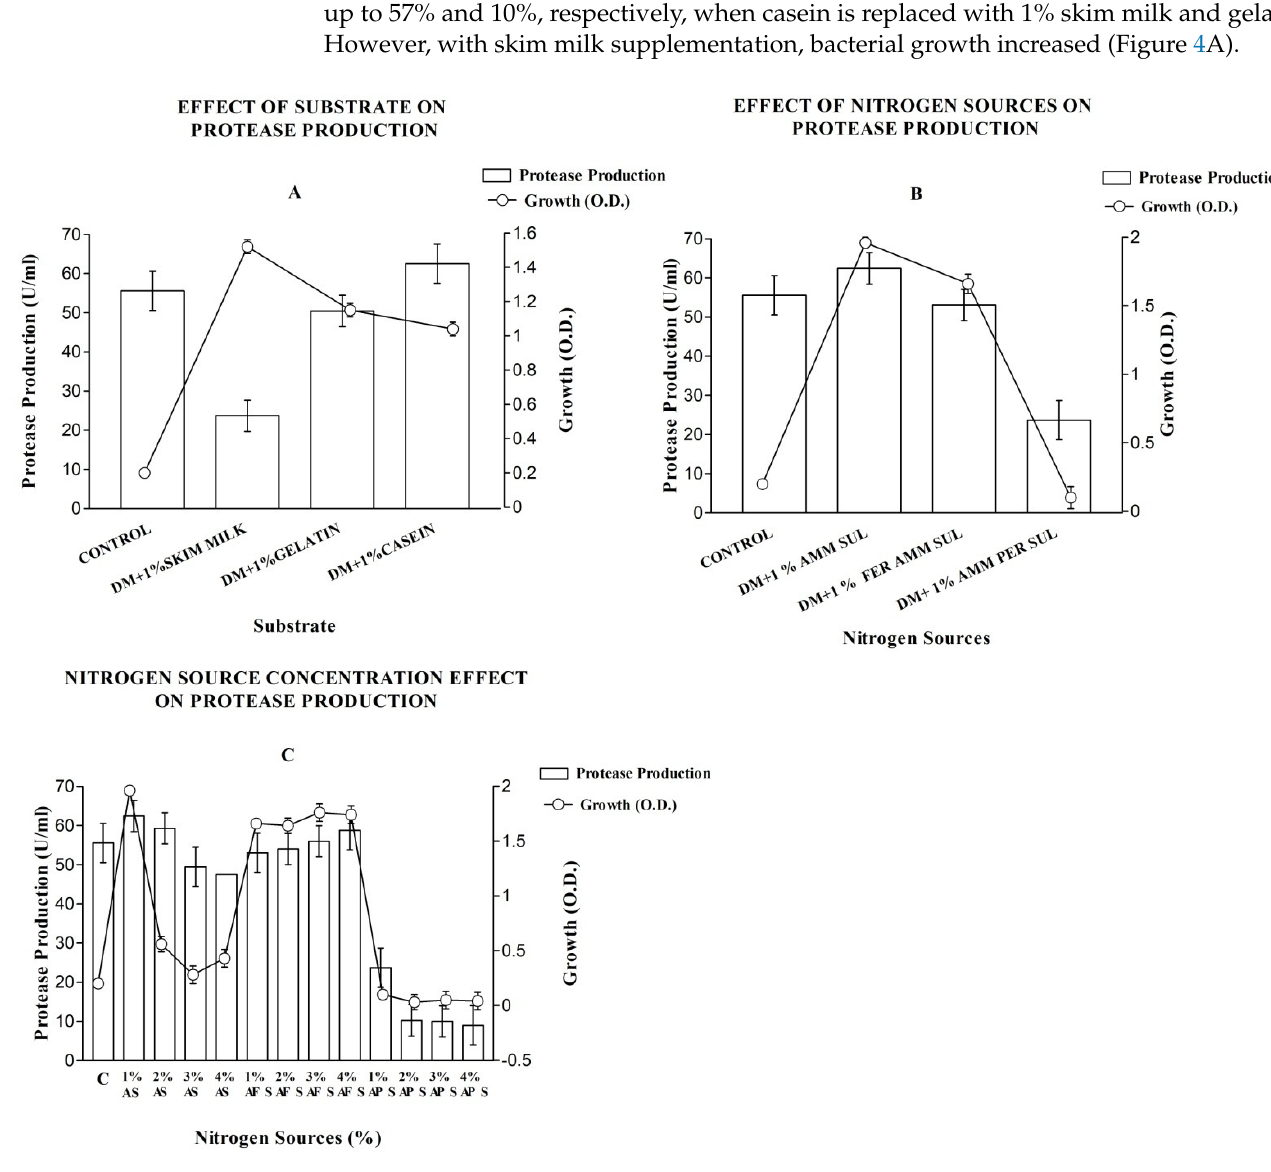
Figure 4. Effect of substrate concentration on extracellular protease production by selected isolate Bacillus subtilis D3L/1. Bar represents enzyme concentration (U/mL),line graph for bacterial growth; ( A ): effect of different substrate on protease production; ( B ): effect of inorganic nitrogen sources on protease production; ( C ): effect of inorganic nitrogen sources concentration on protease production.